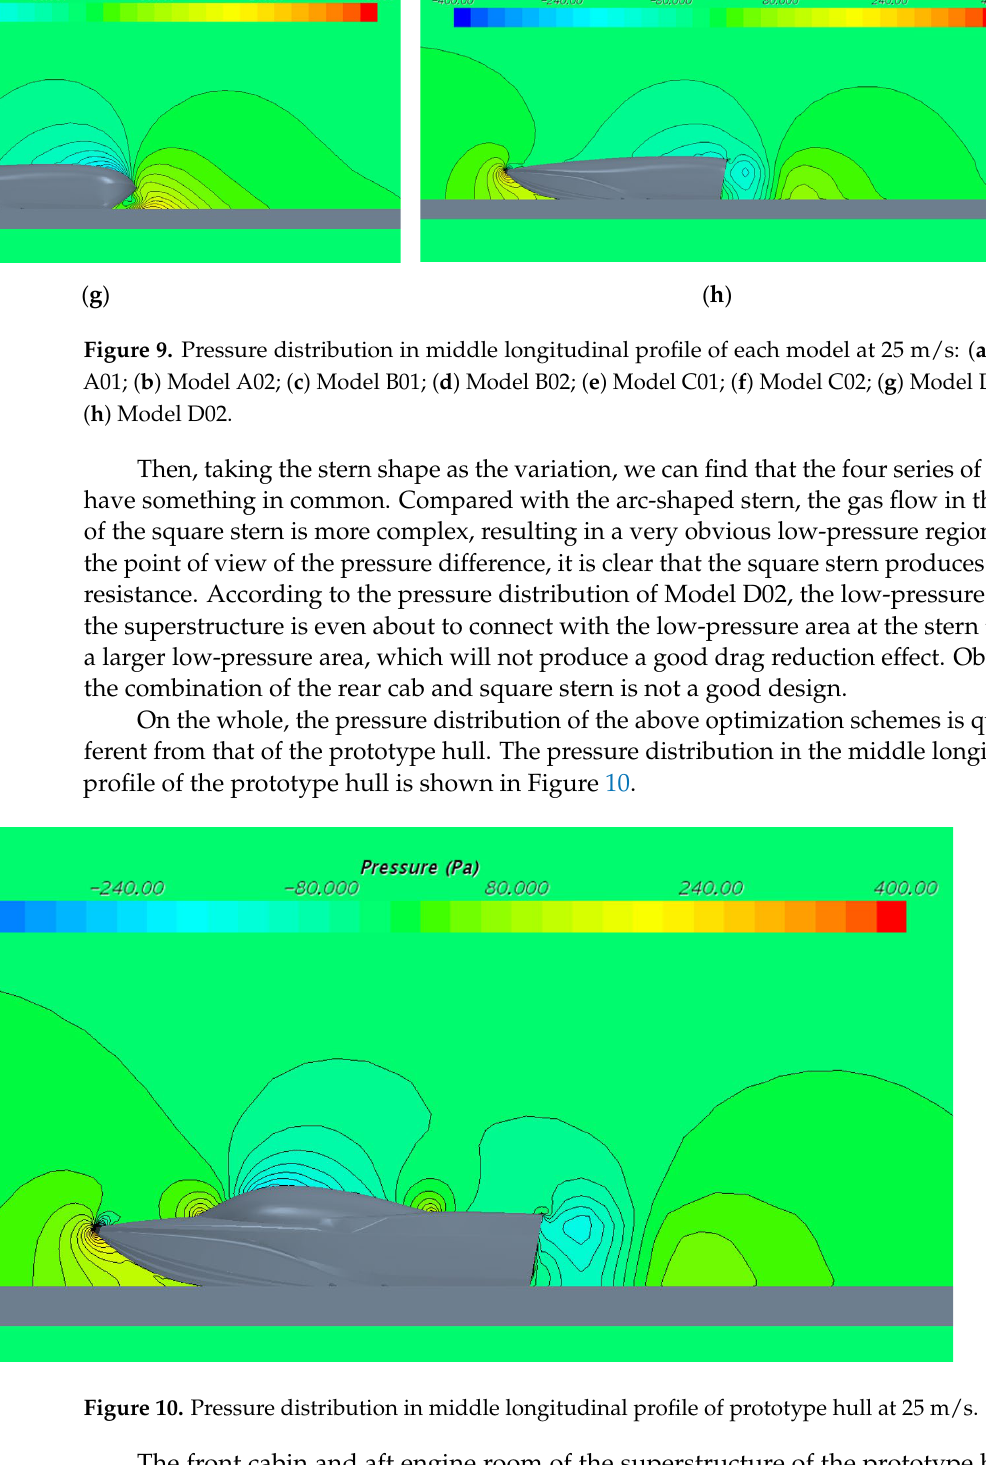
Figure 10. Pressure distribution in middle longitudinal profile of prototype hull at 25 m/s.